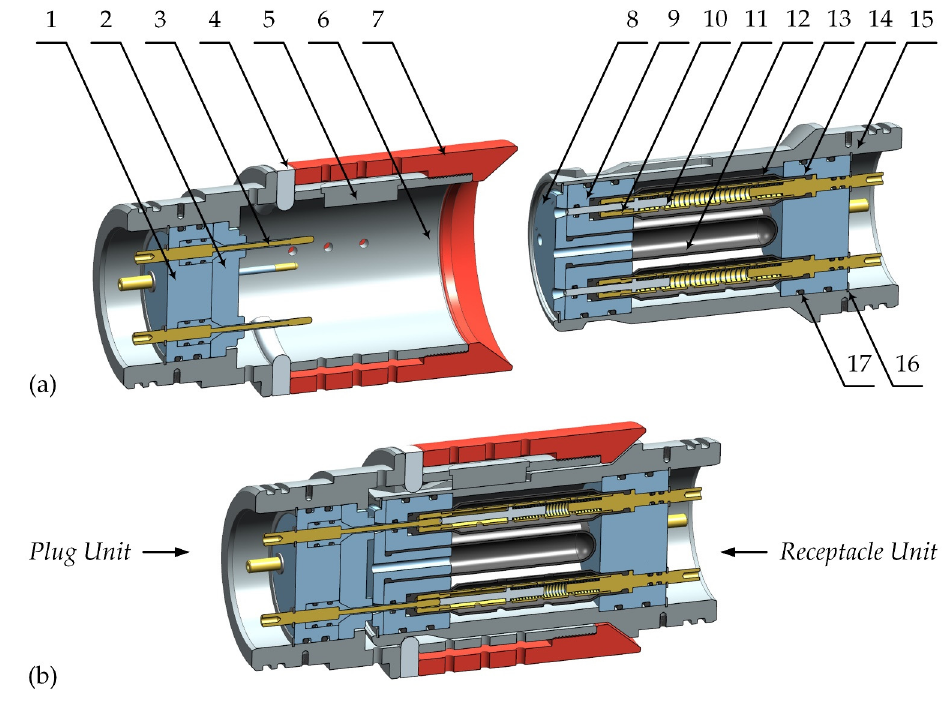
Figure 2. A schematic illustration of ( a ) the de-mated state and ( b ) the fully mated state of the proposed wet-mateable electrical connector: 1-plug pedestal; 2-plug orifice plate; 3-contact pin with an insulating layer; 4-latching member; 5-aligning key; 6-plug shell; 7-dust cap; 8-receptacle orifice plate; 9-receptacle front pedestal; 10- electric connection; 11-moveable stopper; 12-primary resilient bladder; 13-secondary resilient bladder; 14-receptacle rear pedestal; 15-receptacle shell; 16-retaining ring; 17-O-ring.